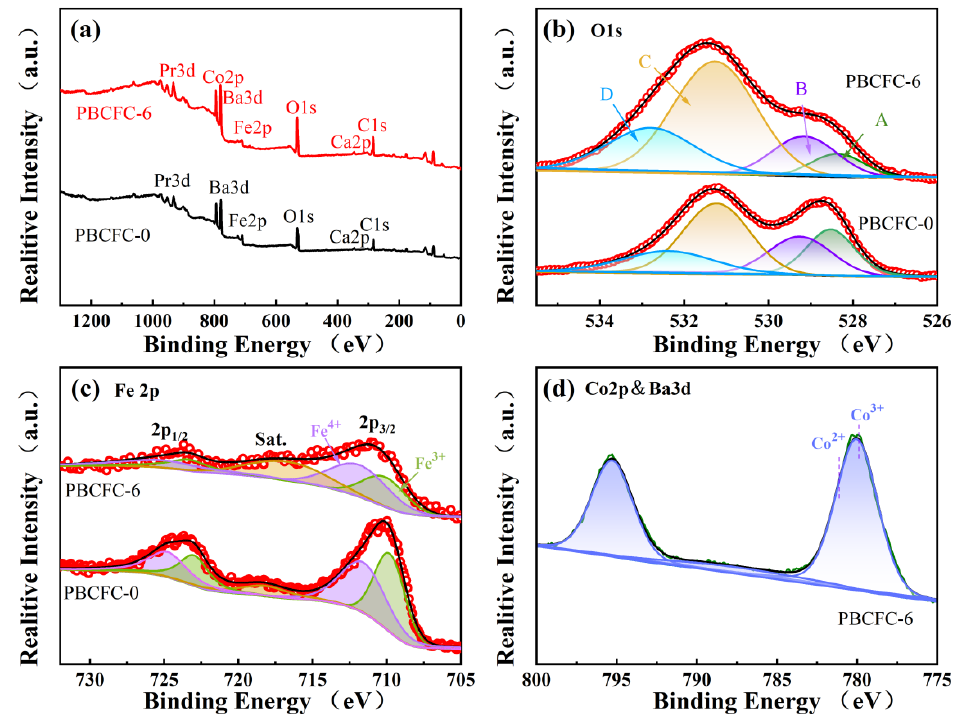
Figure 5. Full spectrum spectra ( a ), O 1s ( b ), Fe 2p ( c ), and Co 2p and Ba 3d spectrum ( d ) of PBCFC-x (x = 0, 2, 4, 6, 8) powders.